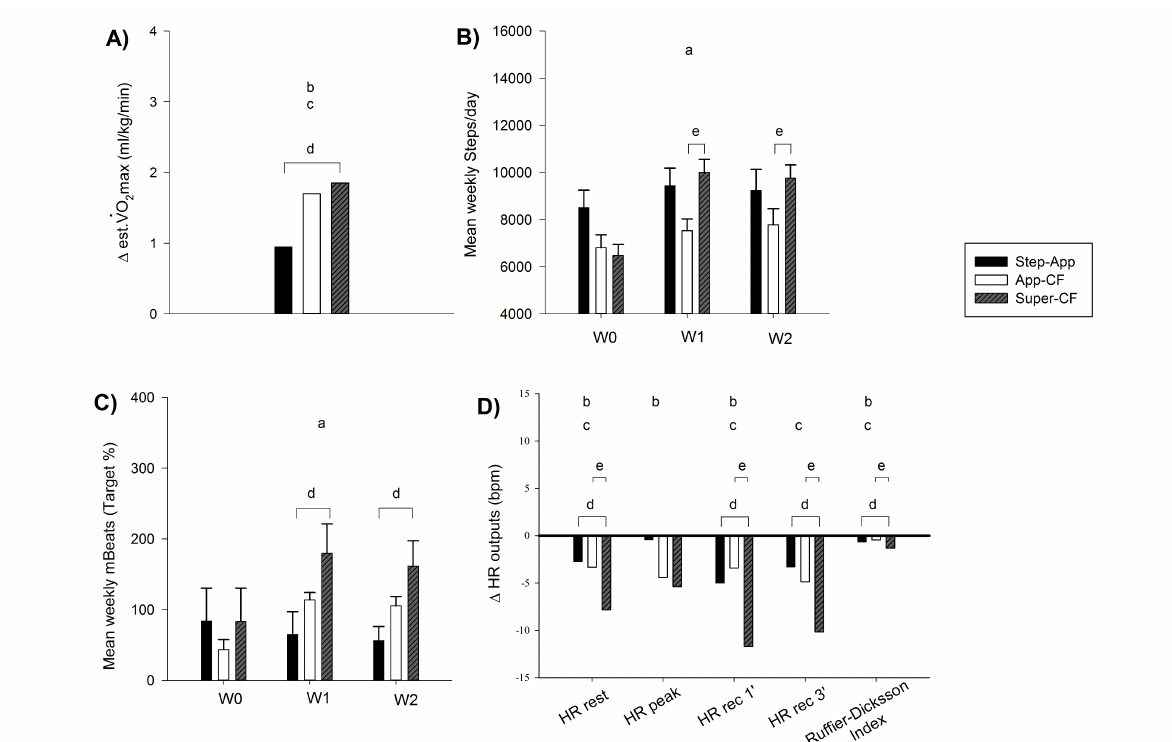
1 (W1), and week 2 (W2). C) Mean weekly mBeats expressed as percentage of target mBeats (for the definition of mBeats see methods section). D) Week 2 - baseline Heart rate (HR) deltas at rest, for the maximal recoded during a squat exercise test (peak), 1 and 3 minutes during the recovery from the squat exercise test, and for the Ruffier-Dickson Index as defined in the method section. a, Significant time x group interaction. b, Significant main effect of time. c, Significant main effect of group. d, Significant difference between Step-App group and Super-CF group. e, Significant difference between CF-App and Super-CF